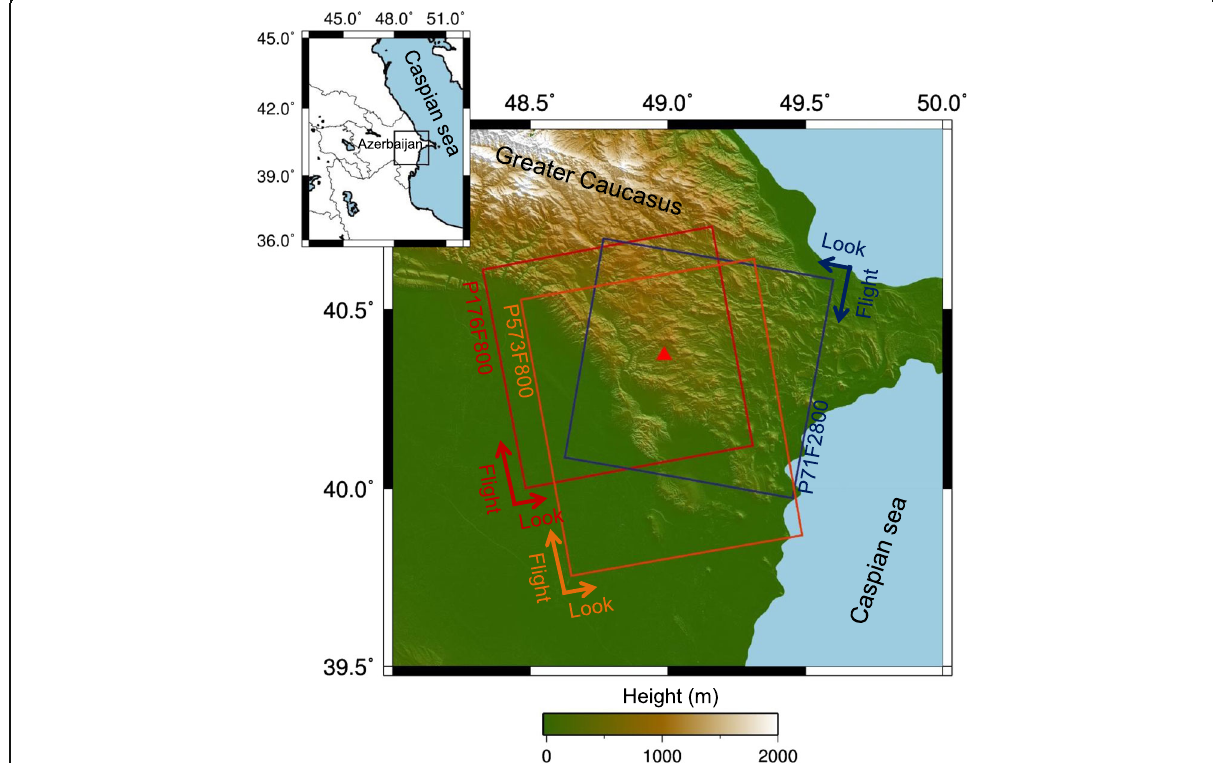
Fig. 1 Location of Ayaz-Akhtarma mud volcano, indicated with red triangle. Orange, red, and blue rectangles represent the imaging areas covered by ALOS/PALSAR ascending, ALOS-2/PALSAR-2 ascending, and ALOS-2/PALSAR-2 descending tracks, respectively. Upper-left panel indicates the location of Azerbaijan and Caspian